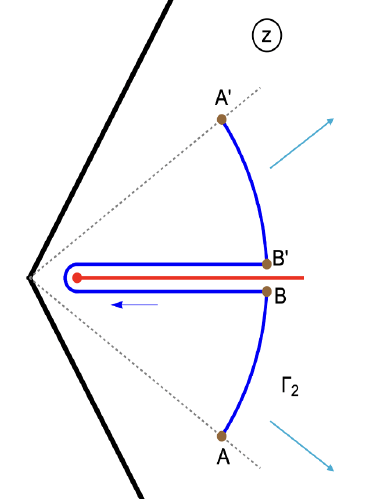
Figure 1. The z -plane with Γ 2 in blue. The solid rays ϕ = ± π/ (2 α ) in black and the dashed rays ϕ = ± π/ (2 α + 2) in